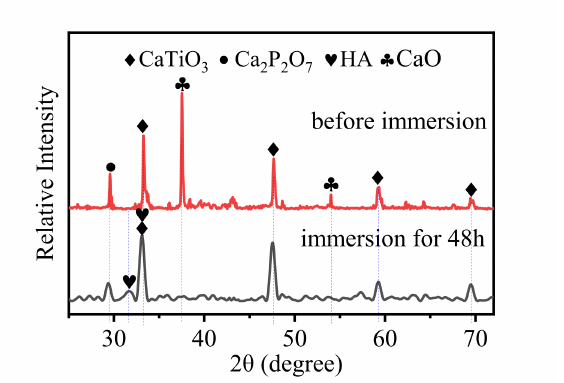
Figure 10. Micromorphology of surface deposits of substrate ( a ) and Ca/P ceramic coating ( b ) after 48 h of immersion in SBF solution.